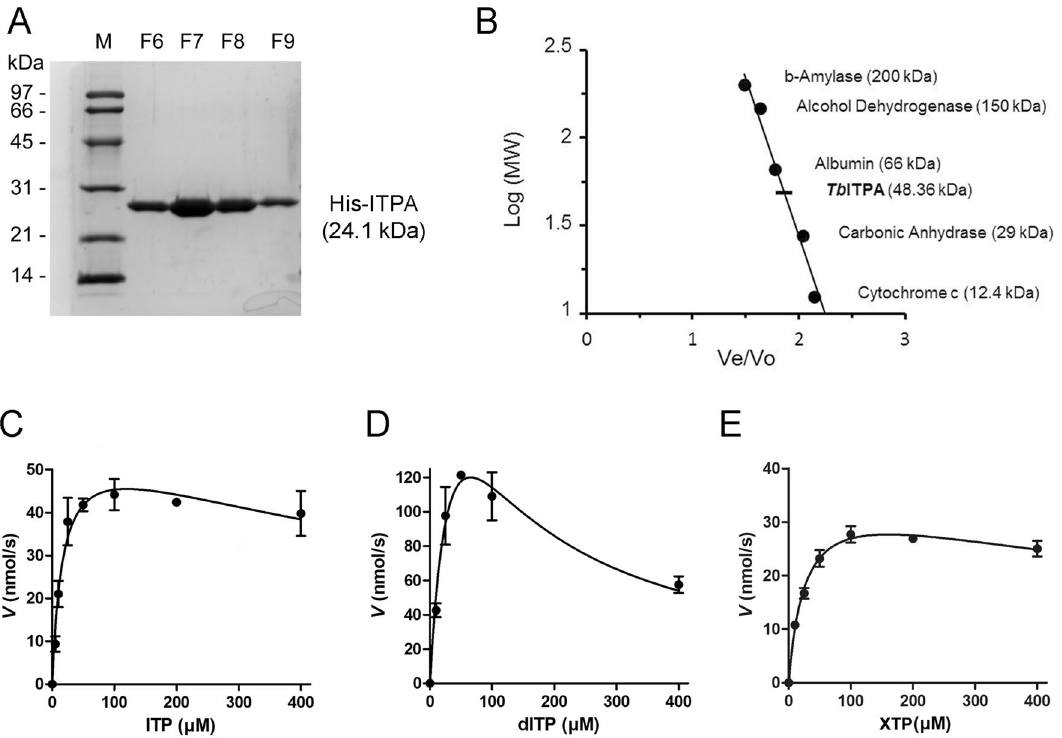
Figure 2. TbITPA exhibits NTP pyrophosphatase activity over non-canonical NTP substrates. ( A ) Purified protein was separated on SDS-PAGE gel and stained with Coomassie. M, molecular weight markers; F6-F9, fractions containing purified TbITPA were obtained after affinity and anion exchange chromatography. ( B ) A sample of purified TbITPA protein was applied to a Superdex 200 10/300 GL column (GE Healthcare) in 50 mM phosphate, 0.15 M NaCl, pH 7.2 and eluted at 0.5 mL/min in the same buffer. The molecular weight (MW) determination is extrapolated by comparing the Ve/Vo ratio for TbITPA to the Ve/Vo of protein standards of known molecular weight, Ve = Elution volume of the protein; Vo = Void volume of the column. ( C ) Substrate saturation curves obtained for ITP, ( D ) dITP and ( E ) XTP. Each data point is the mean (± SD) of at least three independent determinations. Reactions were performed and analyzed as described in Materials and Methods. The data were fitted to a non-linear kinetic model for substrate inhibition and analyzed with GraphPad Prism 5 software.